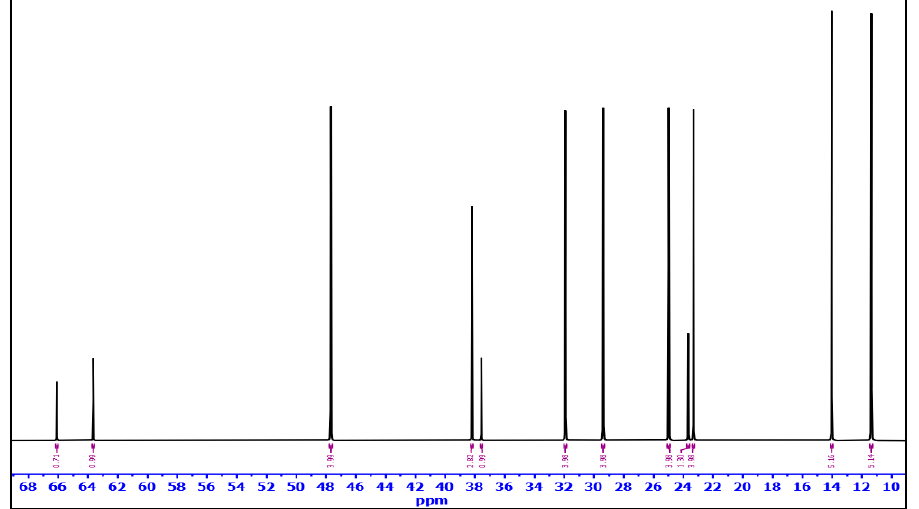
Figure 5. Characterization of PPVP composite by 13 C-NMR spectrometry.